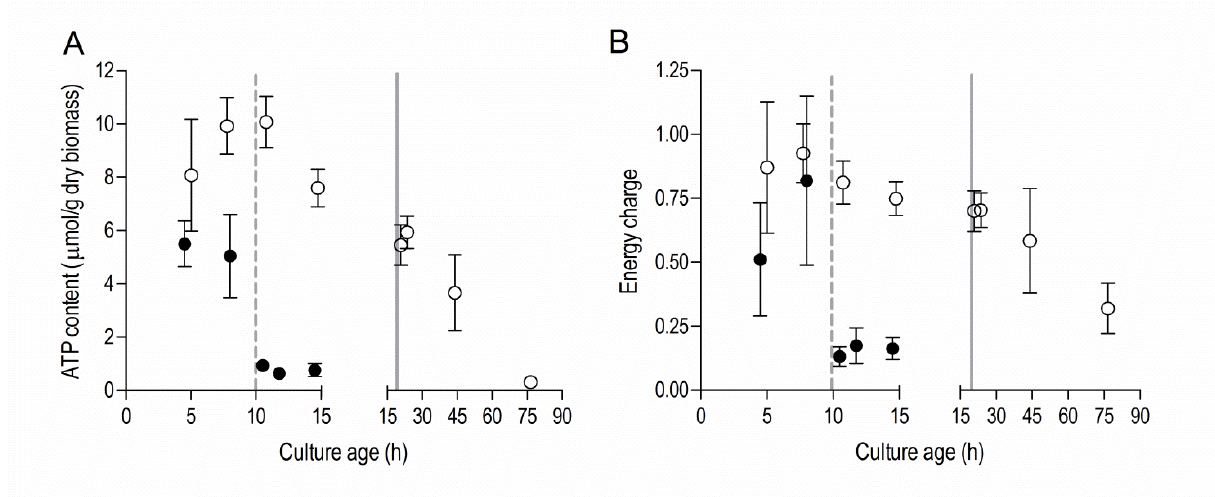
FIGURE 3: Intracellular ATP concentration and adenylate energy charge in aerobic and anaerobic stationary-phase cultures. Cellular ATP content (A) and adenylate energy charge (B) in aerobic (open symbols, ○) and anaerobic (closed symbols, ●) cultures. The dashed vertical line represents glucose exhaustion and the onset of anaerobic SP, the solid vertical line represents ethanol exhaustion and the onset of aerobic SP. Values are shown as averages of duplicate cultures (+/-